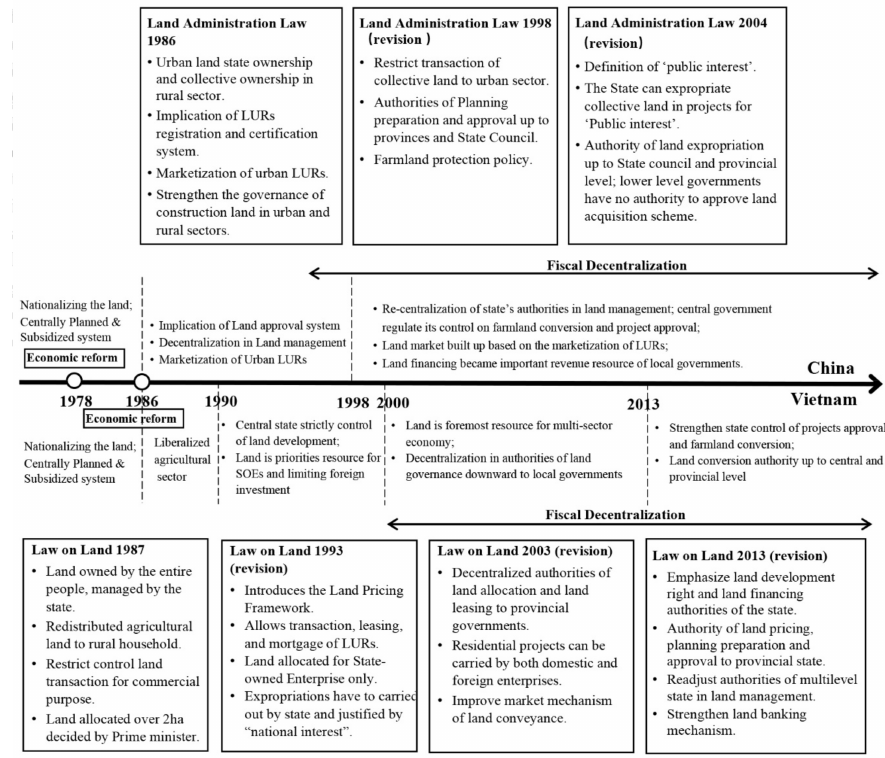
Figure 1. The land policy reform process in China and Vietnam. (Source: the